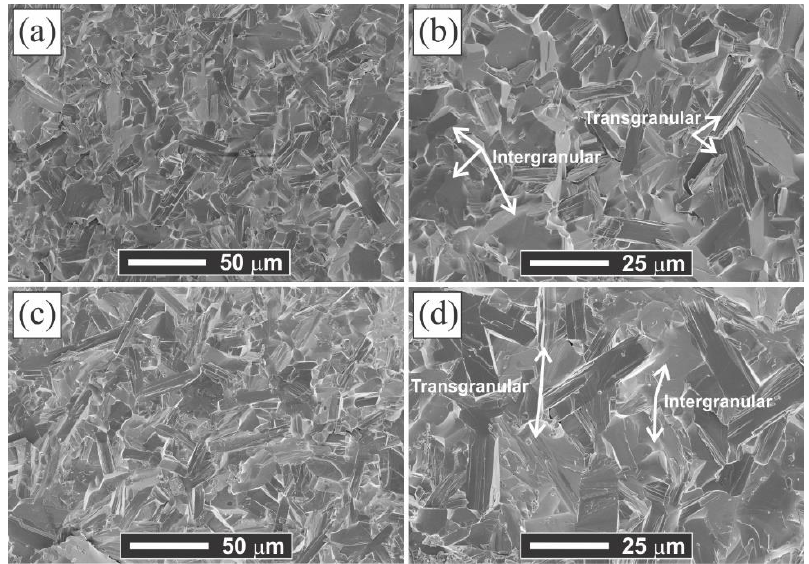
Figure 5. SEM images of the fracture surfaces for ( a , b ) MAX-1200 and ( c , d )